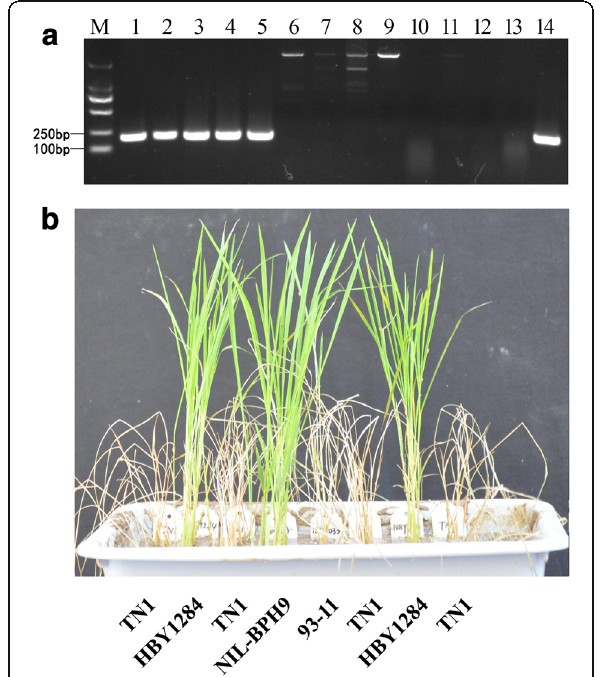
Fig. 4 Development and validation of functional dominant marker